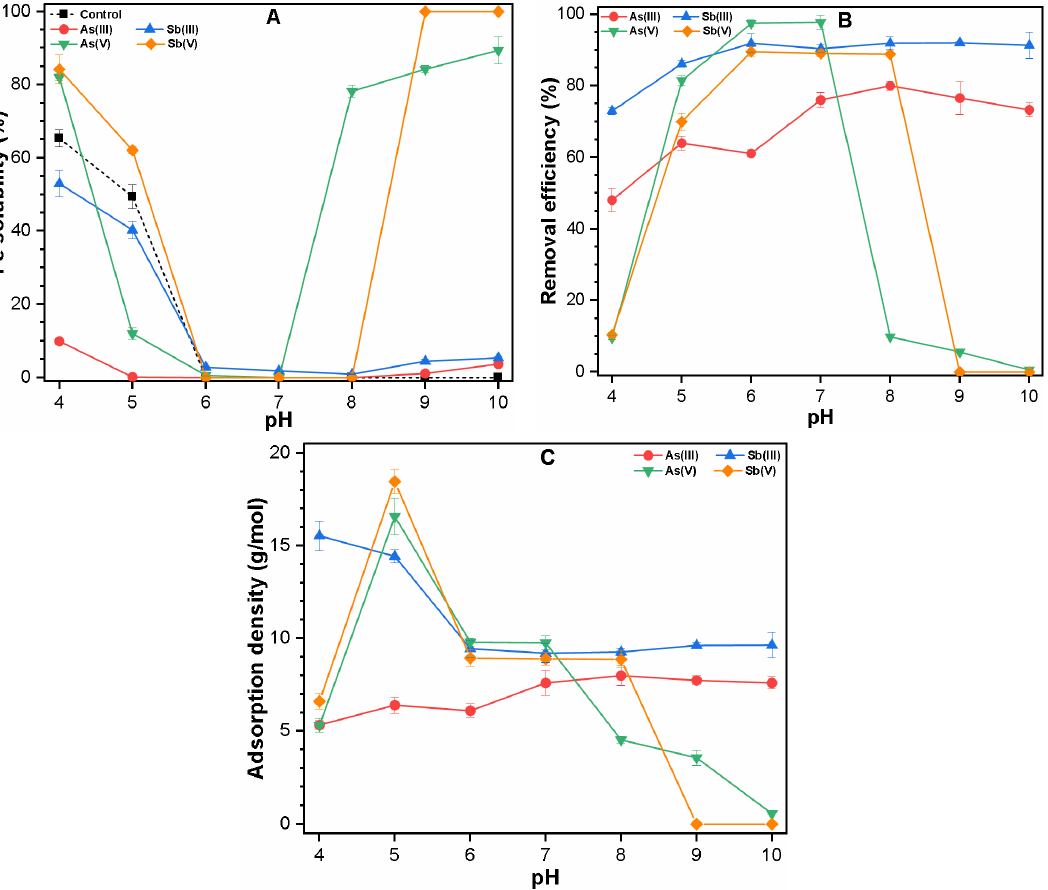
Figure 1. Single solute system of As and Sb species showing ( A ) Fe solubility (%); ( B ) removal efficiency (%); ( C ) adsorption densities (g/mol) under various pH in the range (4–10) with 0.1 mM FC coagulant dose.